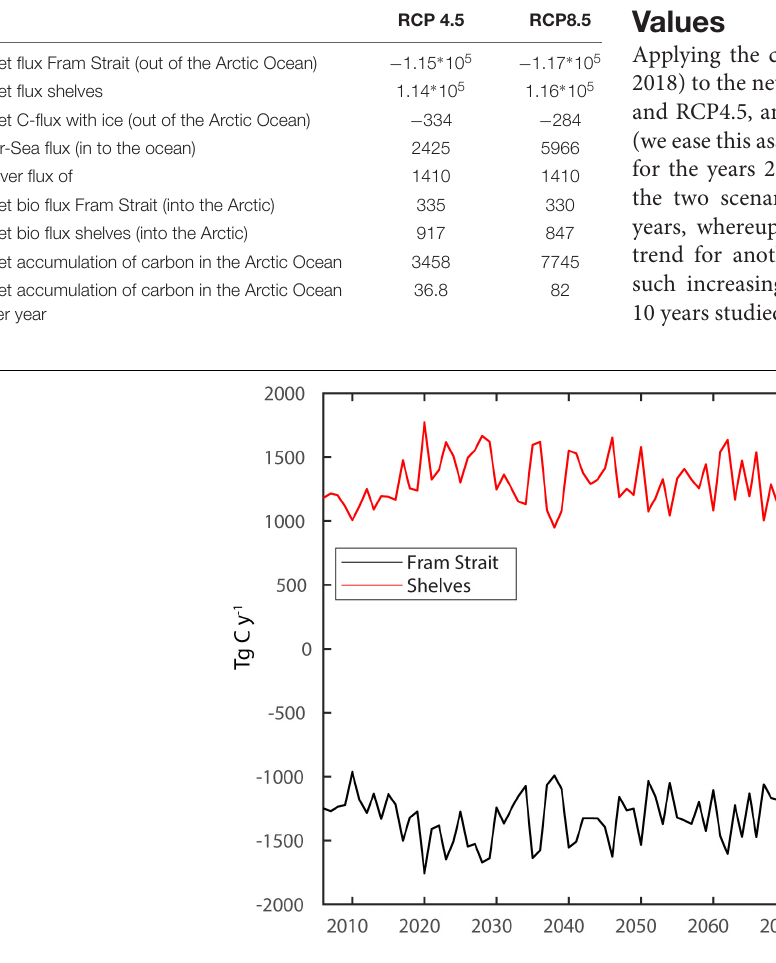
Frontiers in Marine Science |